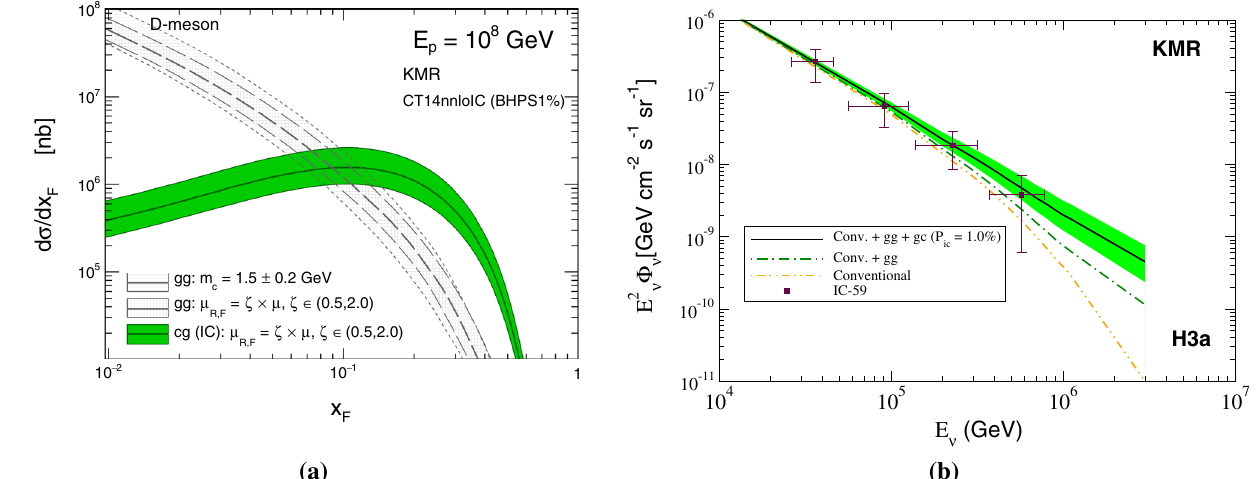
Fig. 10 a The scale and mass uncertainty bands for the Feynman- x F distributions of charm meson produced in pp collisions at the atmo- sphere, derived using the KMR uPDF. In these calculations the scale μ was changed up and down by a factor 2 and charm quark mass was